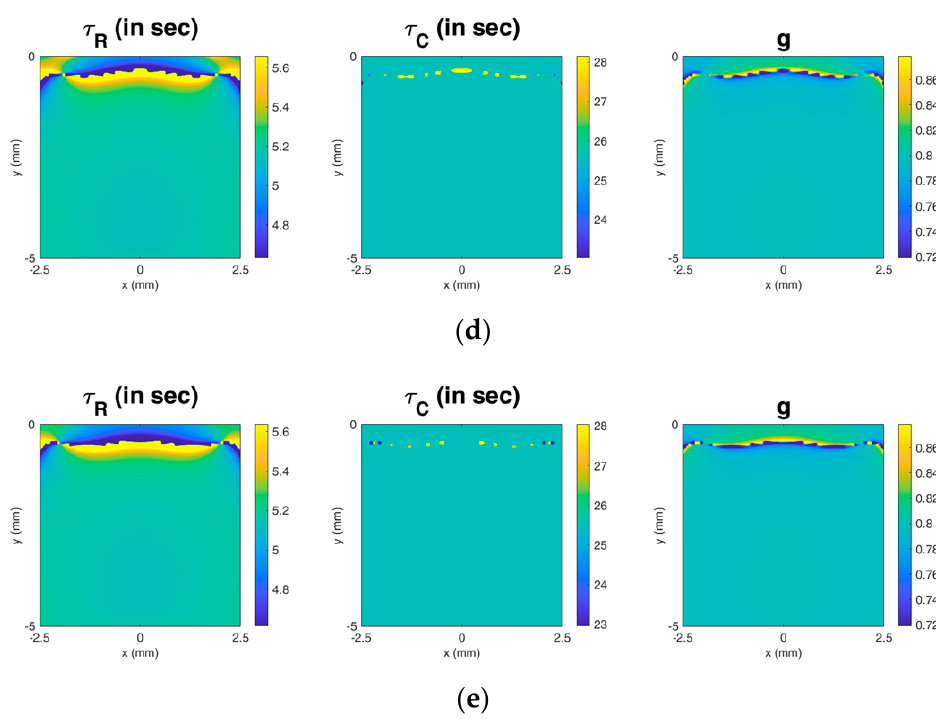
Figure 7. The effect of the selected ultrasound parameters on the pattern of the artifact. In these simulations, the modulus of elasticity, 𝜏 (cid:3019) , and 𝑔 were set as 10 kPa, 5 s, and 0.8, respectively. ( a ) Default setting as described in the main text. ( b ) The same as the default, except that the center frequency of the transducer is 2 MHz. ( c ) The same as the default, except that the transducer has a − 6 dB beamwidth of 1.5 mm along the lateral direction and a − 6 dB beamwidth of 8.0 mm along the depth direction. ( d ) The same as the default, except that the location of the focus of the acoustic radiation force excitation is ( 𝑥 (cid:2868) , 𝑦 (cid:2868) ) = (0 mm, 0.5 mm). ( e ) The same as the default, except that the location of the focus of the acoustic radiation force excitation is ( 𝑥 (cid:2868) , 𝑦 (cid:2868) ) = (0 mm, − 0.5 mm).